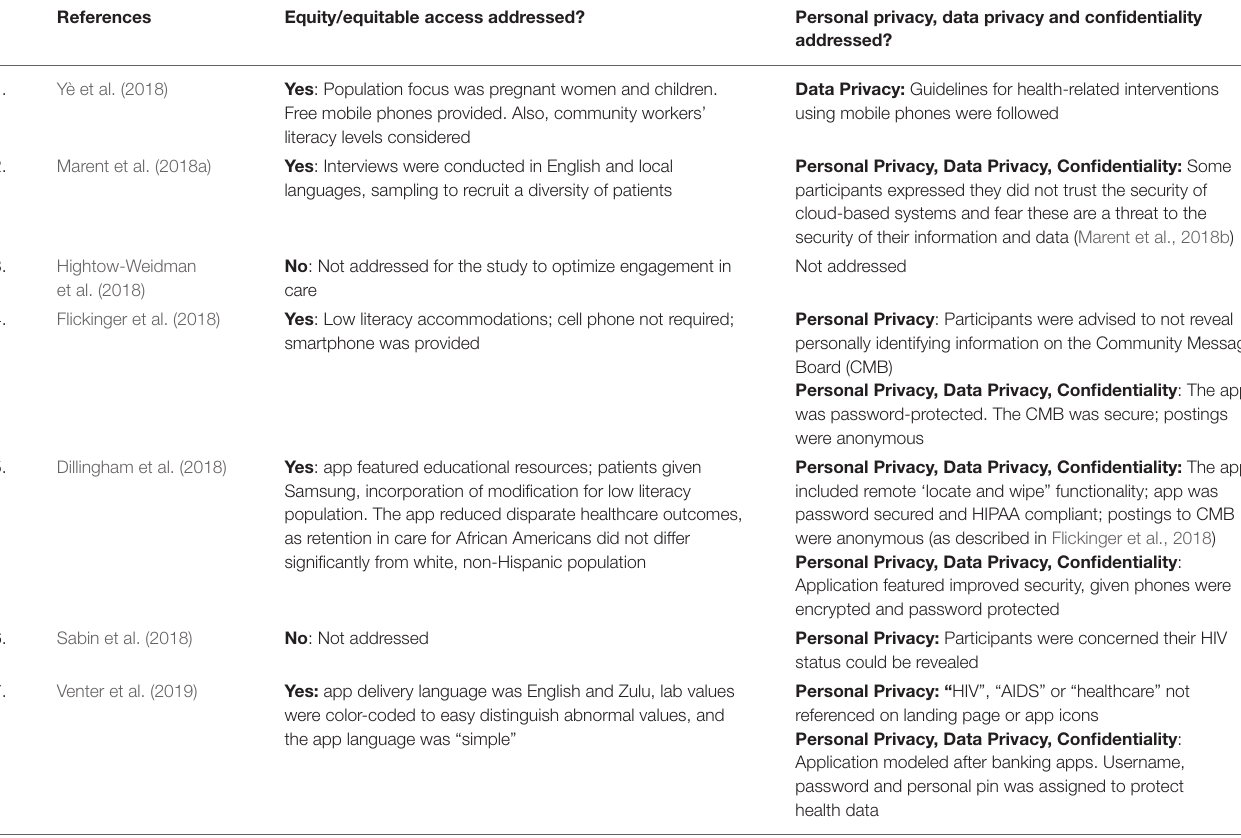
TABLE 4 | Summary of equitable access, privacy, confidentiality, and security aspects for mHealth articles